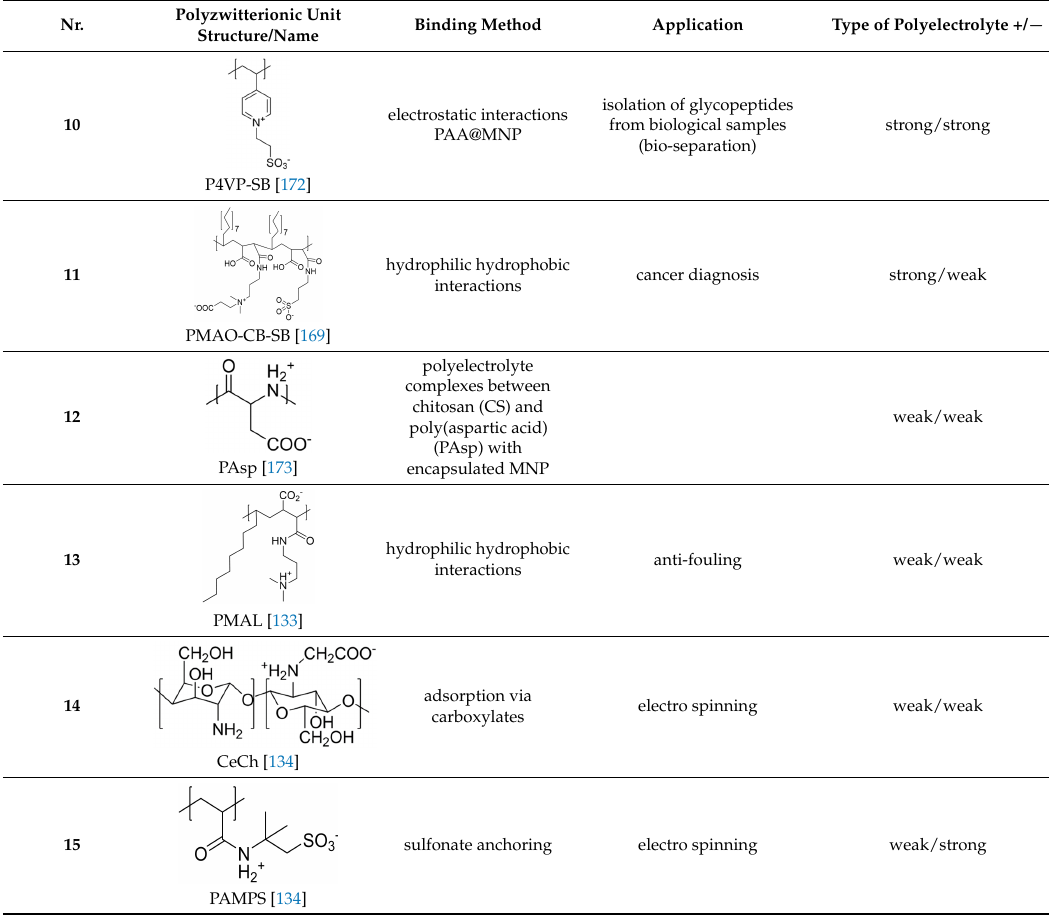
Table 3. Structures, binding method, potential application (if provided), and type of polyelectrolyte combination for polyzwitterions which were used for surface functionalization of MNP via the formation of polyelectrolyte complexes, hydrophilic/hydrophobic interactions, or by addition as surfactant during co precipitation. Nr.